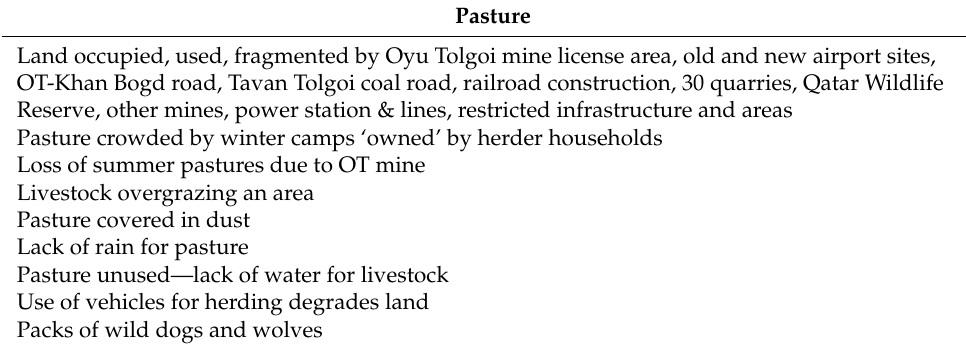
Table 2. Pasture challenges identified by herders.